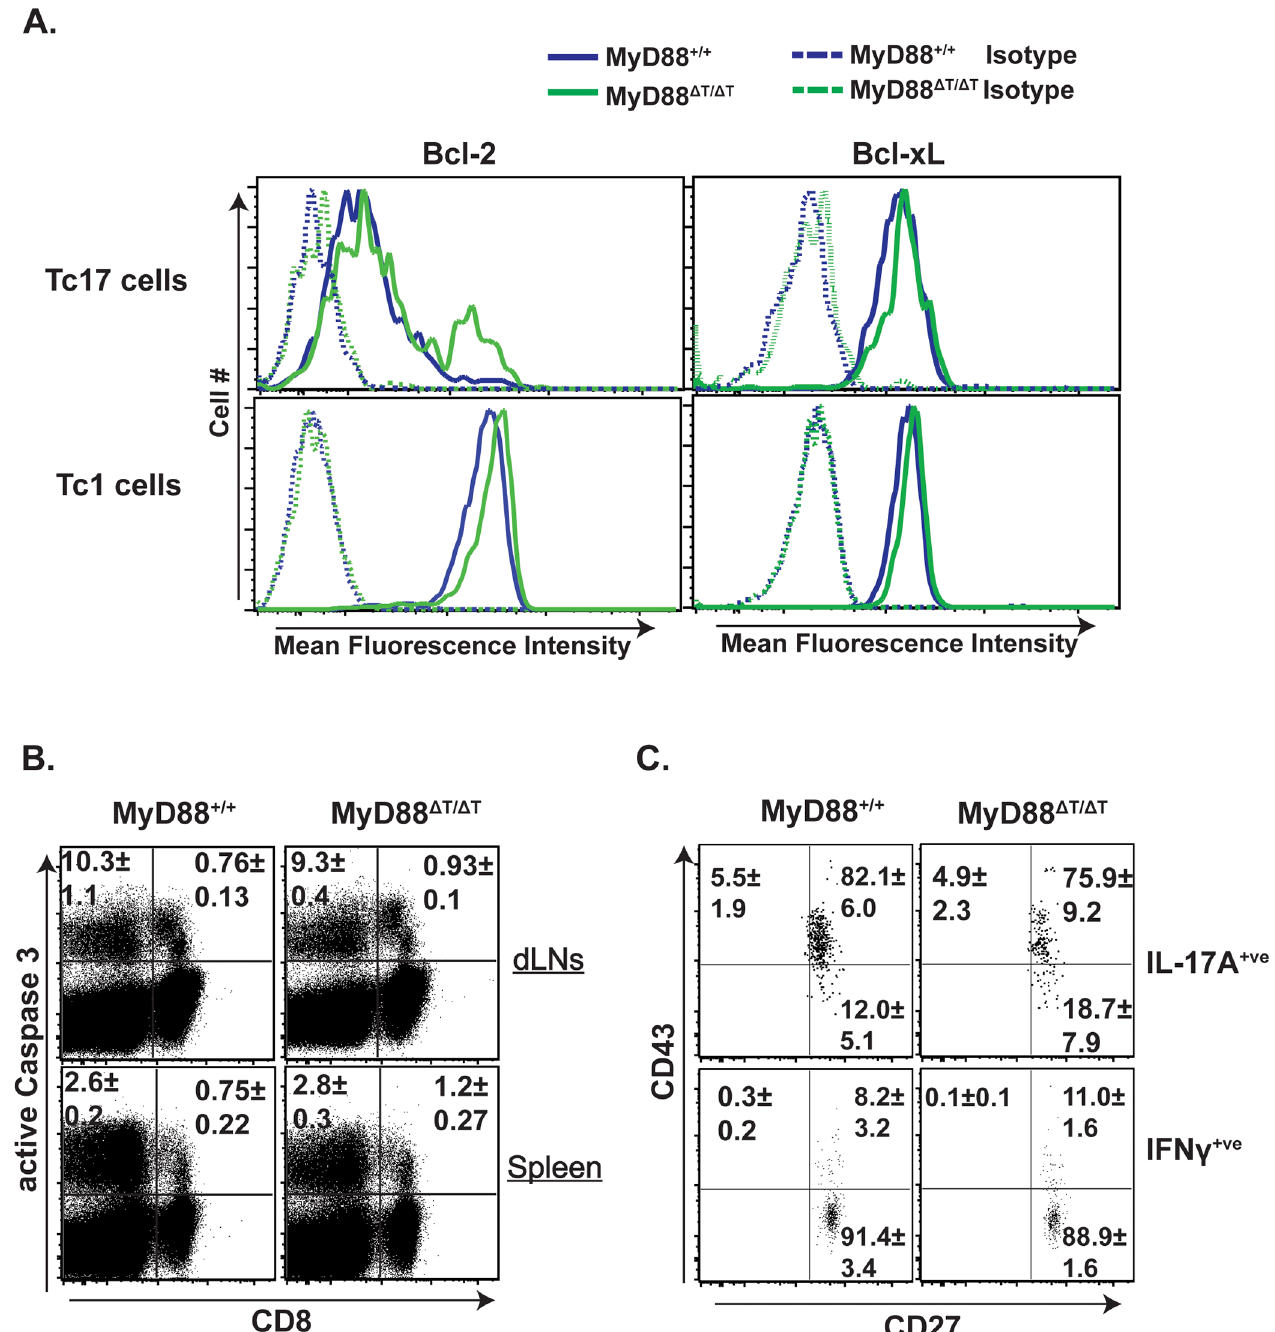
Fig 4. The role of intrinsic MyD88 for effector CD8 + T cell survival. Na ï ve WT and MyD88 Δ T mice were CD4 + T cell depleted and vaccinated with strain #55. Two weeks later dLNs and spleen cells were collected, restimulated and stained for surface markers followed by intracellular staining using BD Perm/Fix and analyzed by flow cytometry. A . MFI of Bcl-2 and Bcl-xL expression in IFN γ + (Tc1) and IL-17A + (Tc17) cells. B . Active Caspase 3 expression. Numbers indicate percent active Caspase 3 expressing cells. C . Surface CD43 and CD27 expression in IL-17A + and IFN γ + cells. Values are the mean ± SD percentage; N = 4 – 5 mice/group. Data is representative of 2 independent